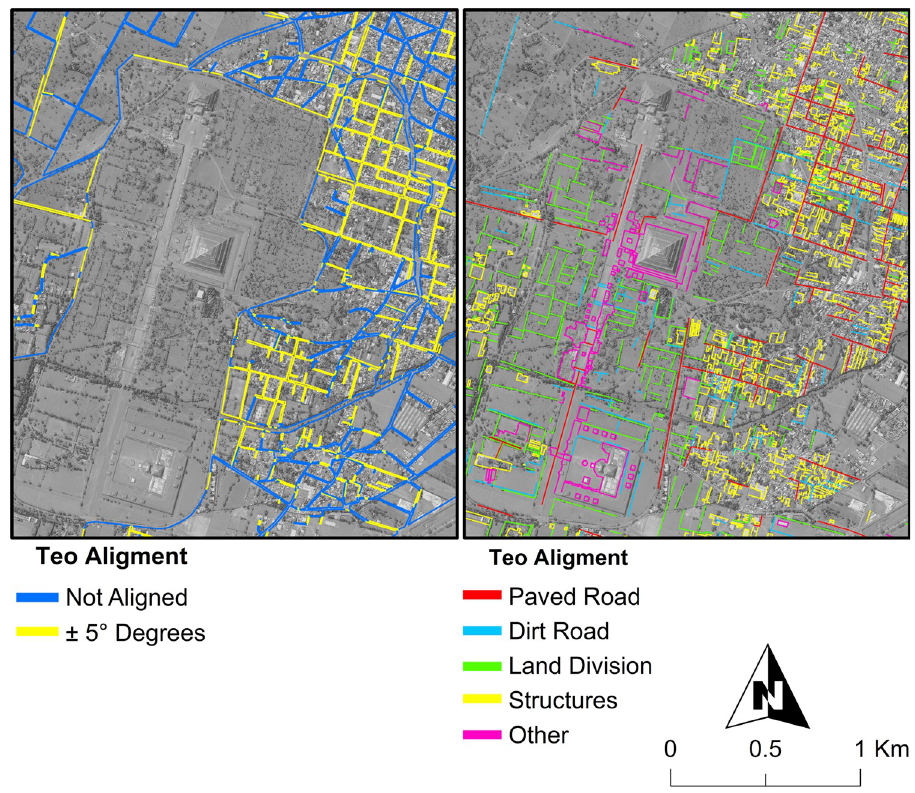
Fig 4. Modern features within ± 5˚ of the Teotihuacan alignments. Left: land divisions. Right: other modern features. Satellite images acquired by Worldview-3, December 12, 2017, courtesy of Maxar Technologies. Published under a CC BY license, with permission from Maxar Technologies, original copyright Digital Globe Foundation 2018.